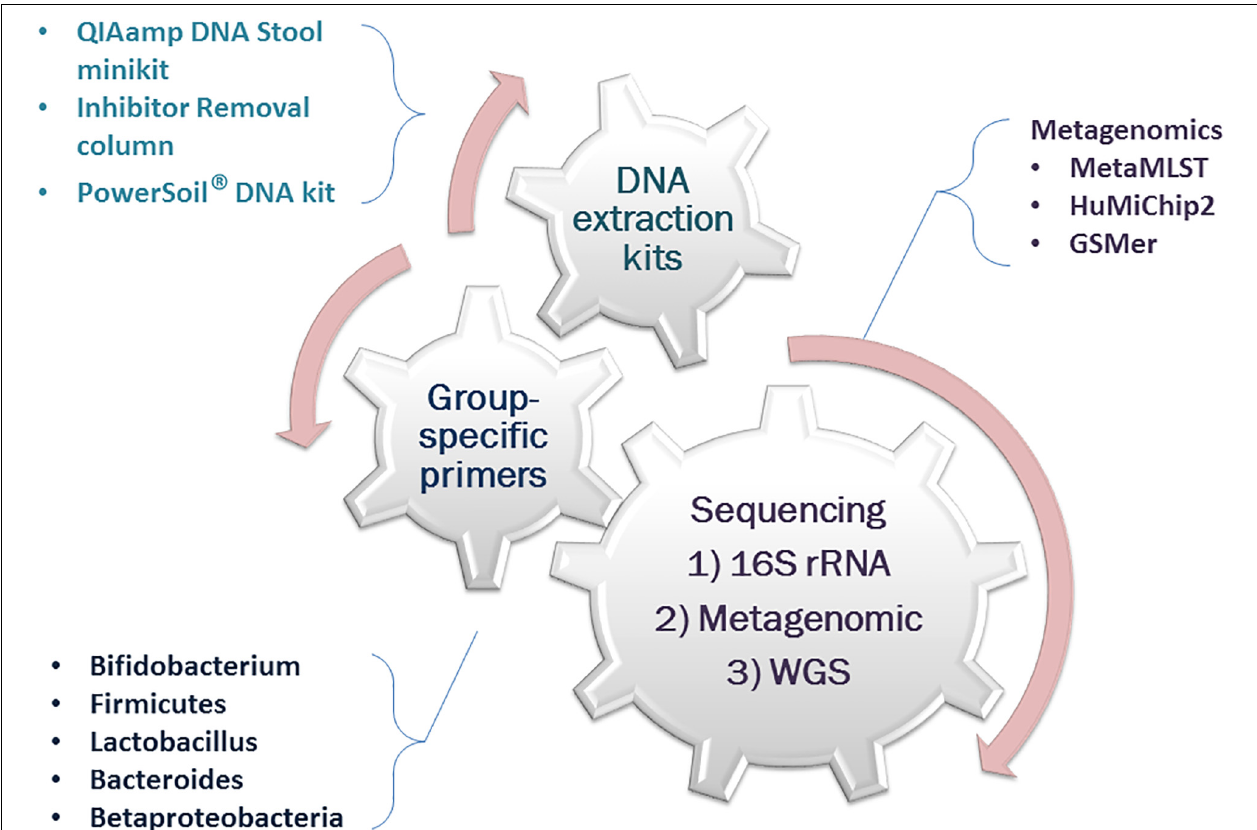
FIGURE 2 | Overview of a few currently available tools for thanatomicrobiome